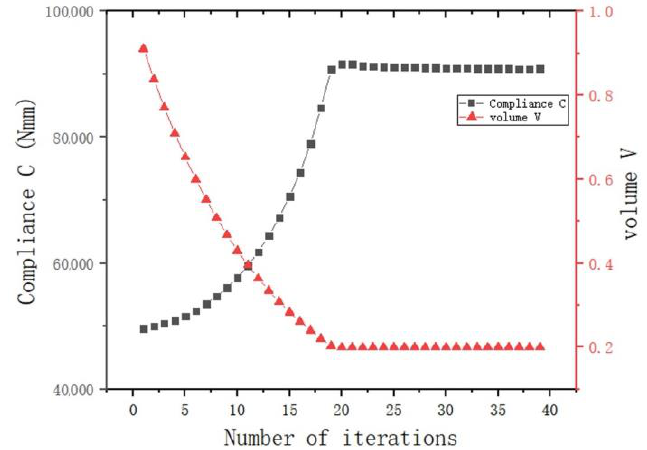
Figure 11. Optimization process under shearing conditions (the black dotted line is the change curve of compliance C, and the red dotted line is the volume-reduction curve).